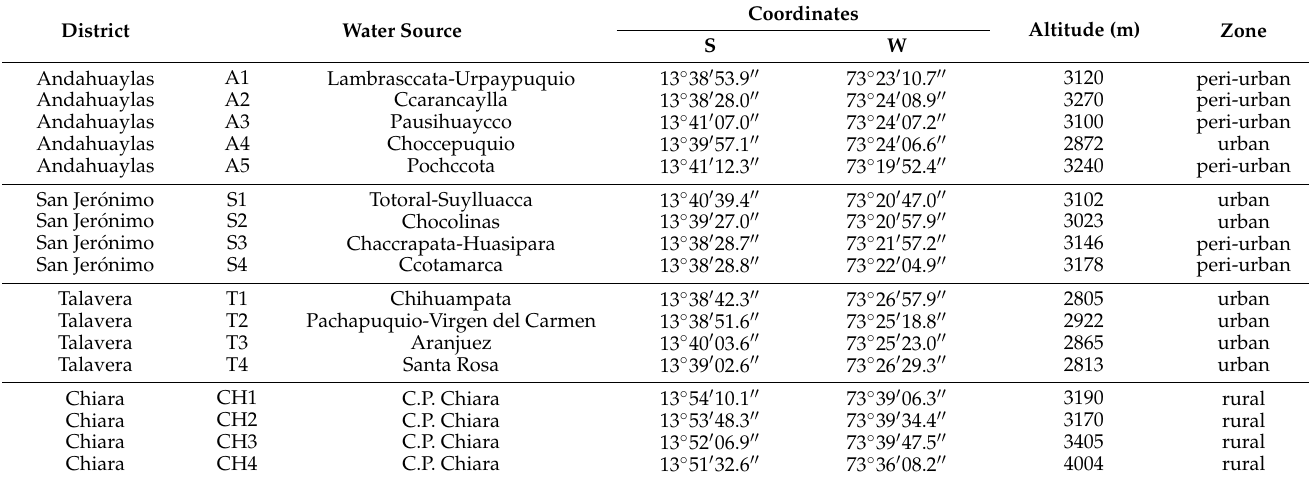
Table 1. Sampling points’ description.